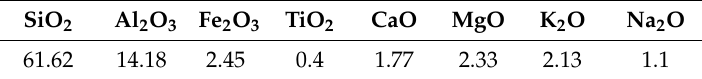
Table 1. Chemical composition of the